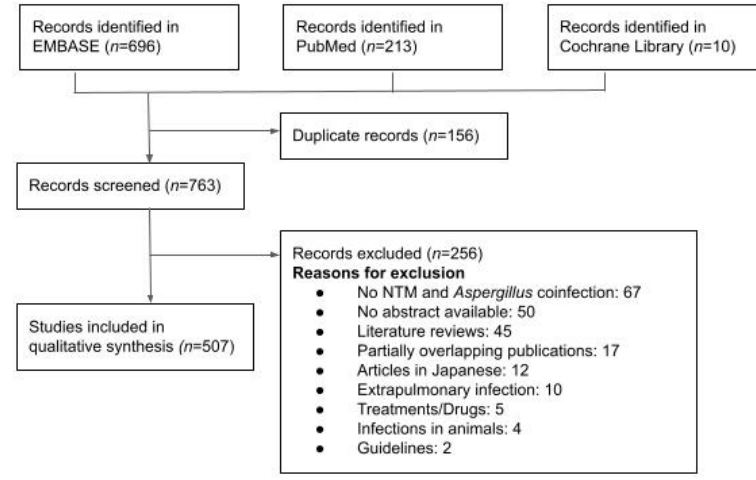
Figure 1. Flow chart for literature search and study selection.